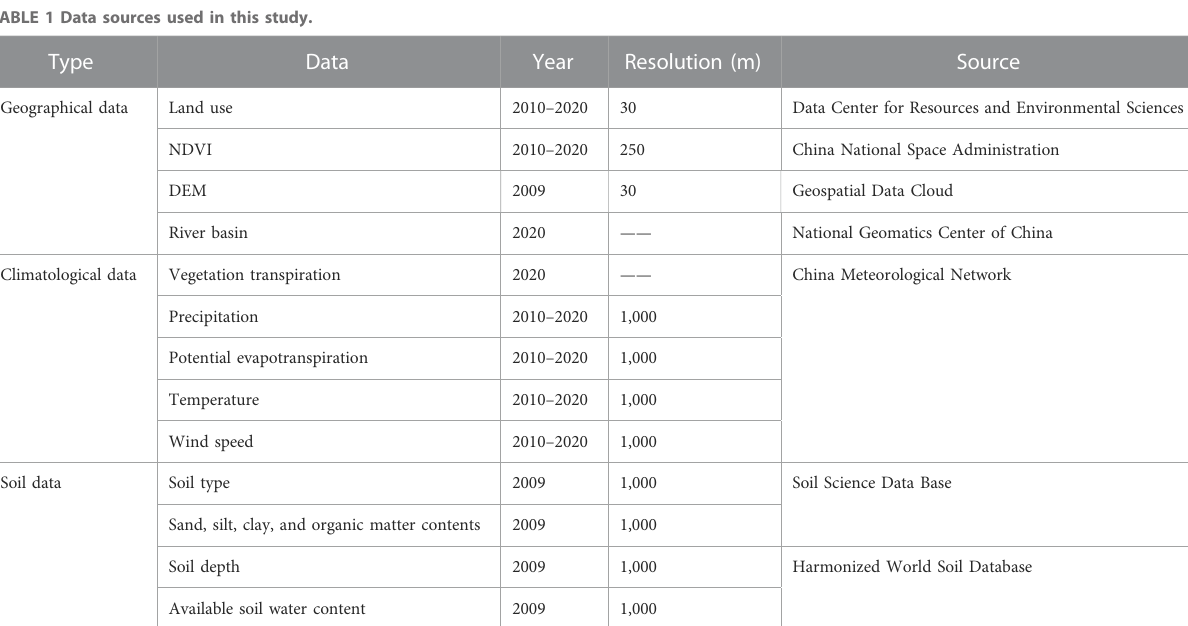
FIGURE 1 Location of UANSTM.